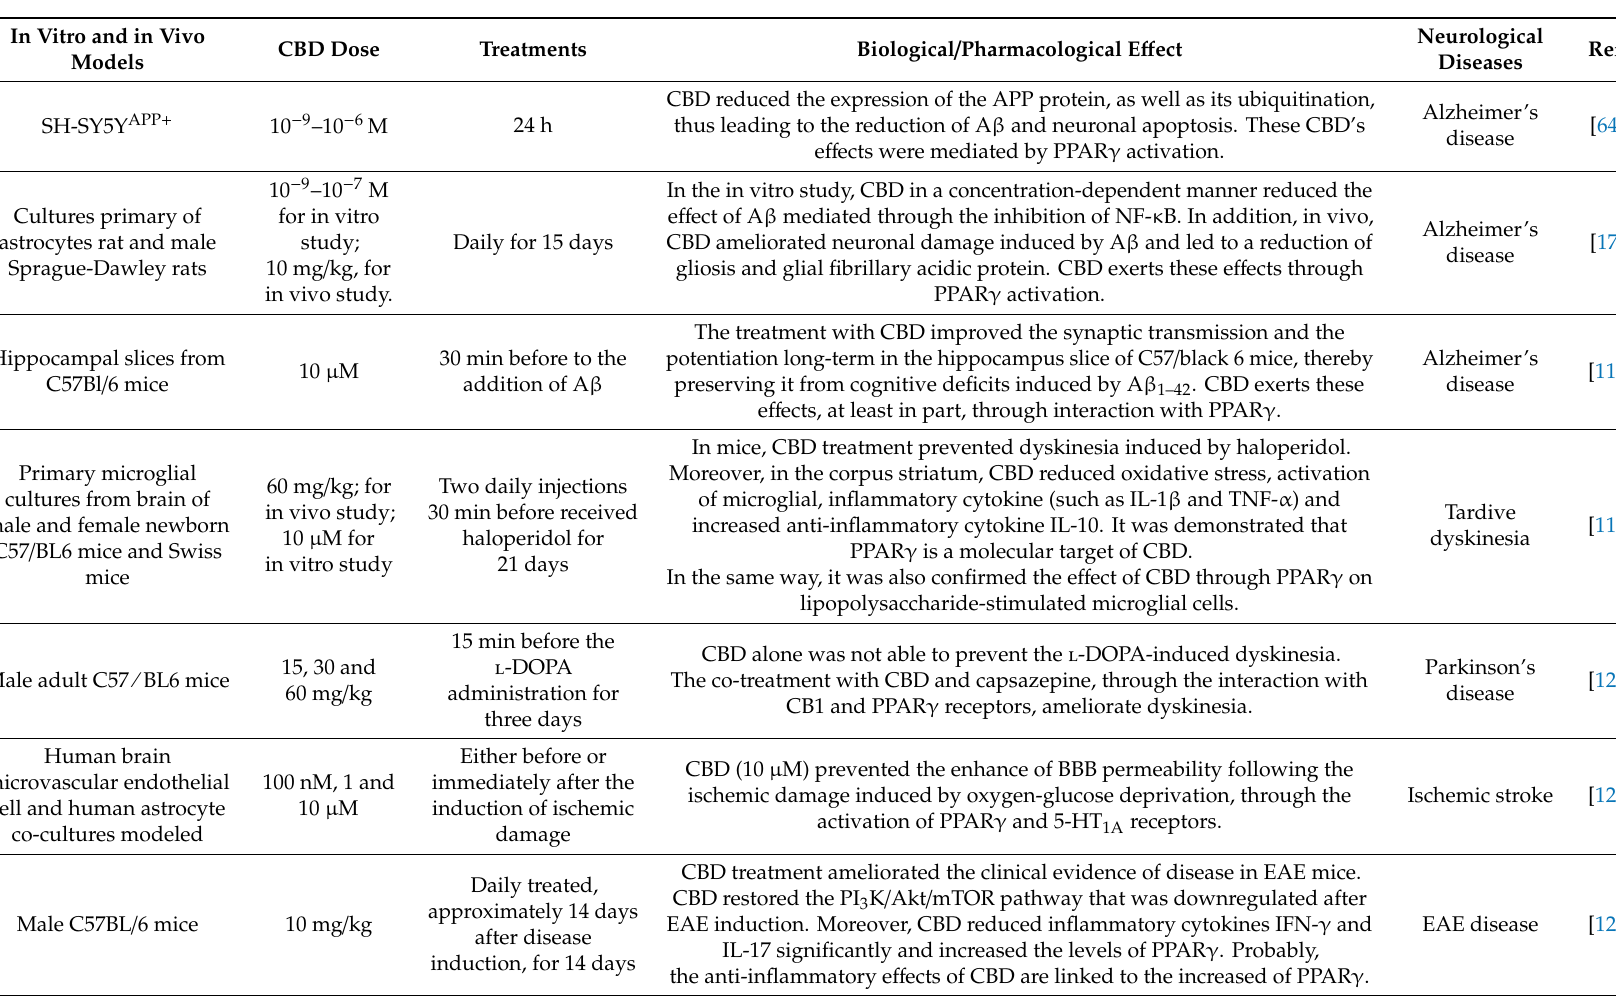
Table 5. Neuroprotective e ff ects of CBD in di ff erent neurological diseases through the activation of the PPAR γ